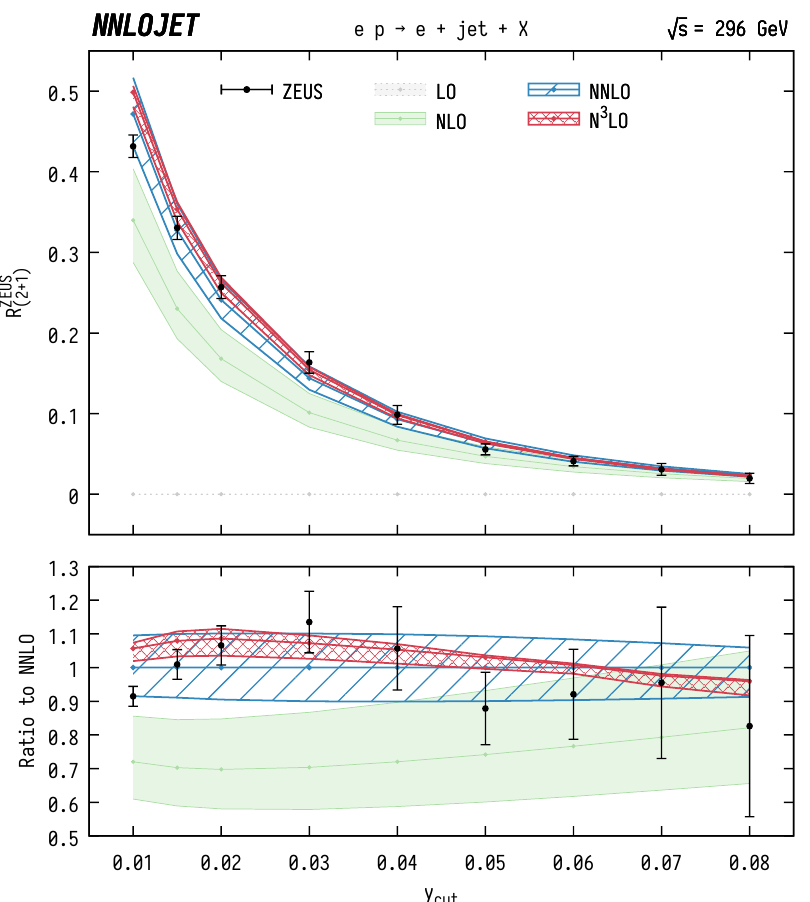
Figure 3 . Comparison of ZEUS data to theoretical predictions up to N 3 LO in QCD for the two-jet rate, normalised according to eq. (4.5). Data are corrected to give parton level results and were extracted from (cid:12)gure 9 of ref. [88]; the error bars show the statistical